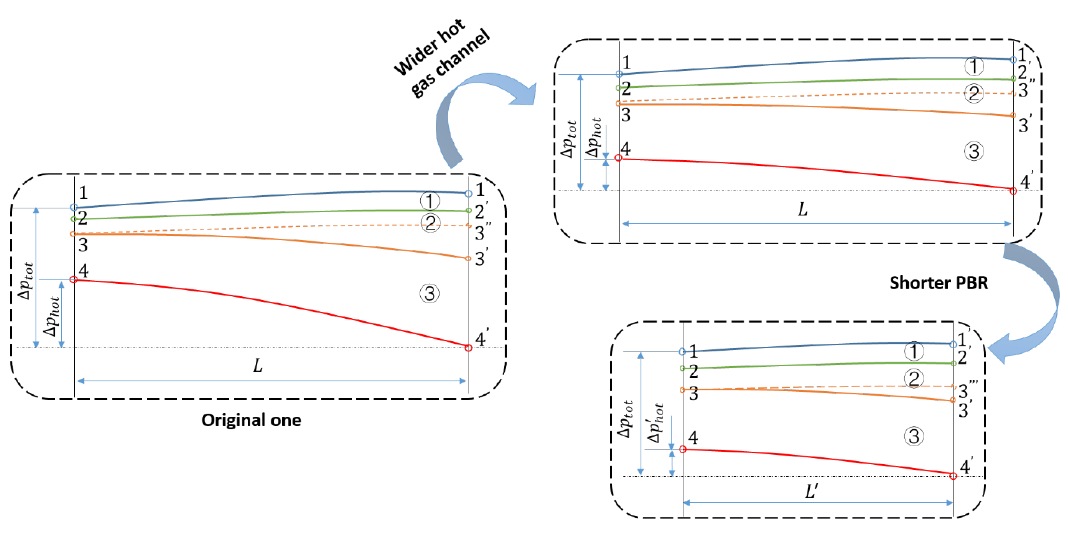
Figure 4. Schematic diagram of the pressure profile along the axial direction at several radial positions under decreased pressure drop conditions within the hot gas channel. 1-1’, outer cold frit interface; 2-2’, inner cold frit interface; 3-3’, outer hot frit interface; 4-4’, inner hot frit interface.